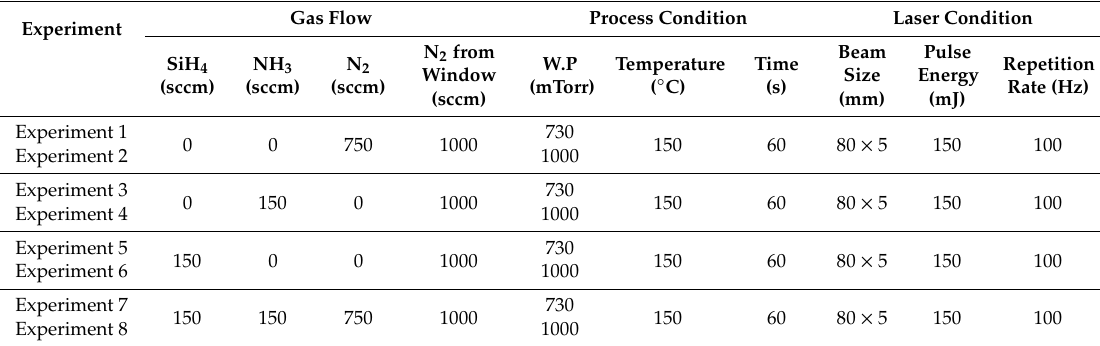
Figure 2. Normalized extinct laser power by propagation in the CVD chamber according to simultaneously generated radio frequency (RF) power with di ff erent gas molecules of ( a ) N 2 , ( b ) NH 3 and ( c ) SiH 4 . Table 1. Experimental parameters of LAPECVD fabrication condition for measurement of I Ext and film